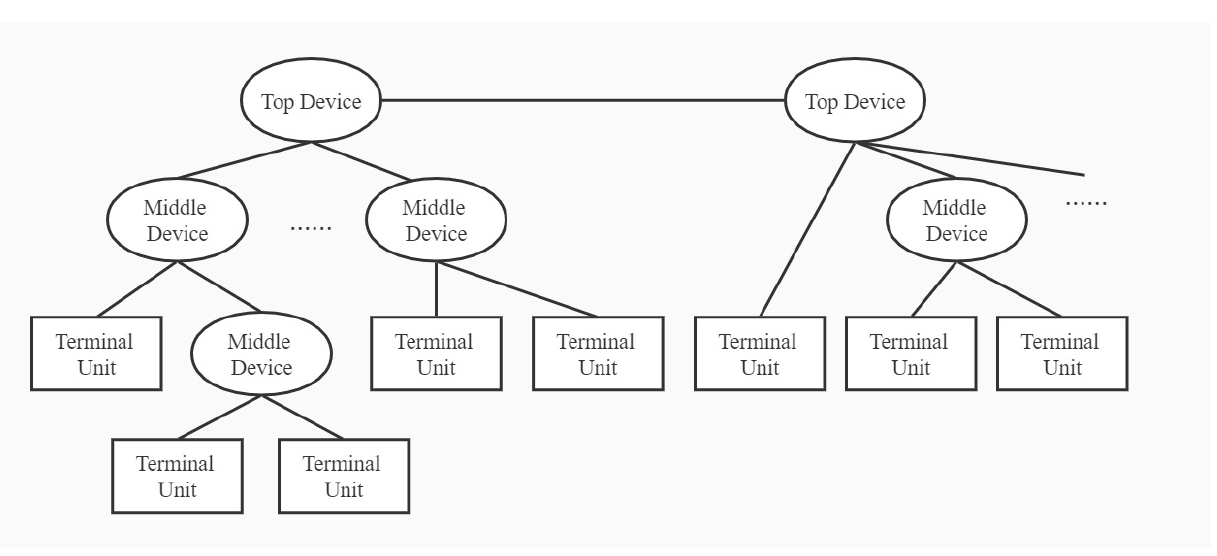
Fig. 1 Embedded device scenario